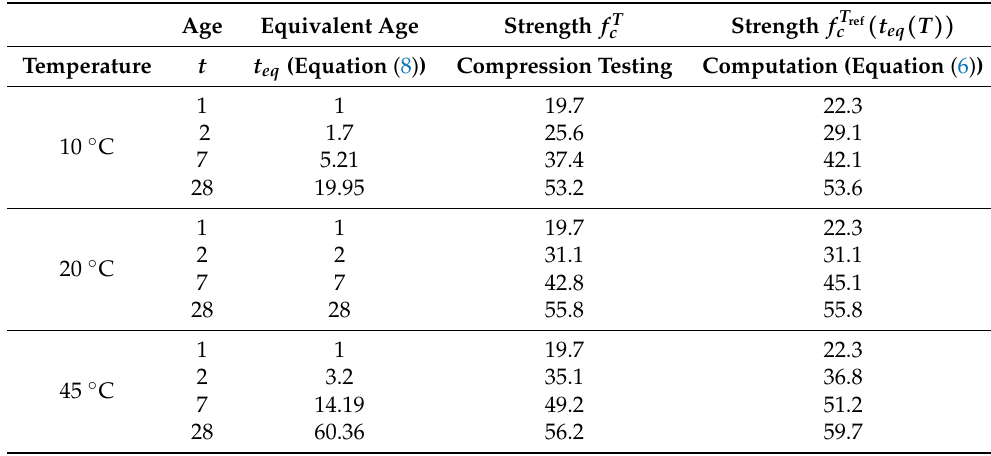
Table 2. Determination of apparent activation energy from compressive